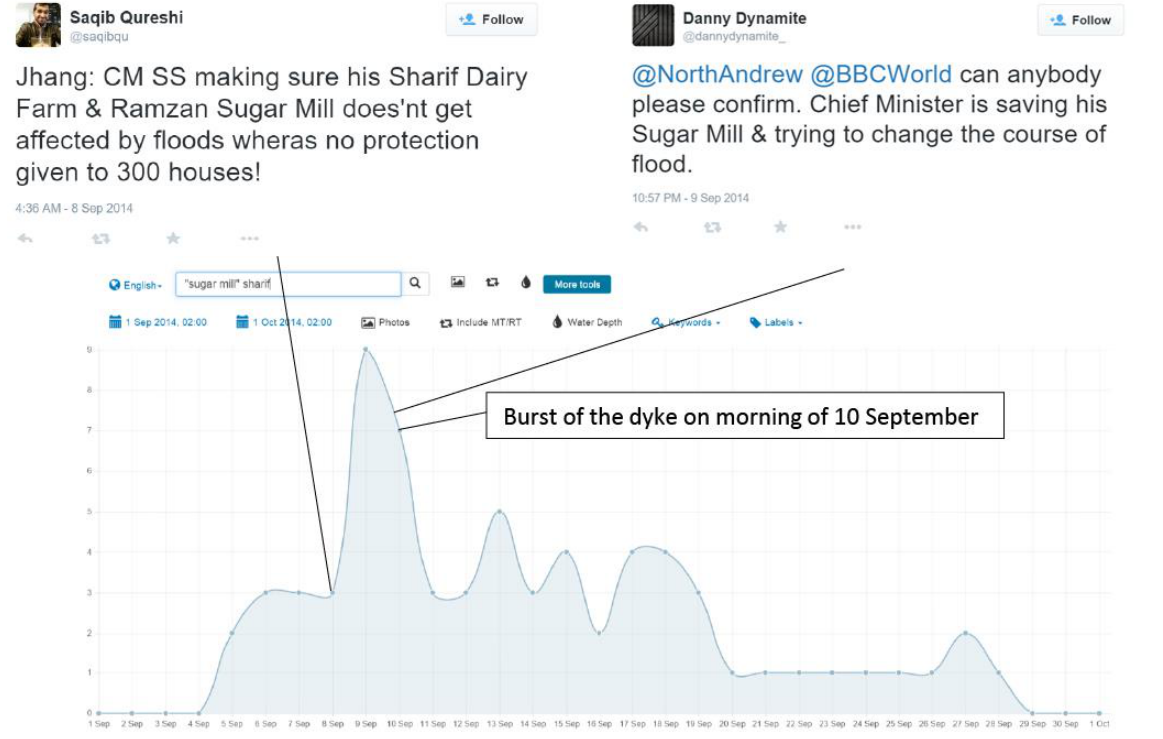
Figure 5. Twitter activity in Pakistan surrounding the blowing of flood defenses around Athara Hazari for the protection of the Sugar Mills at Trimmu and the city